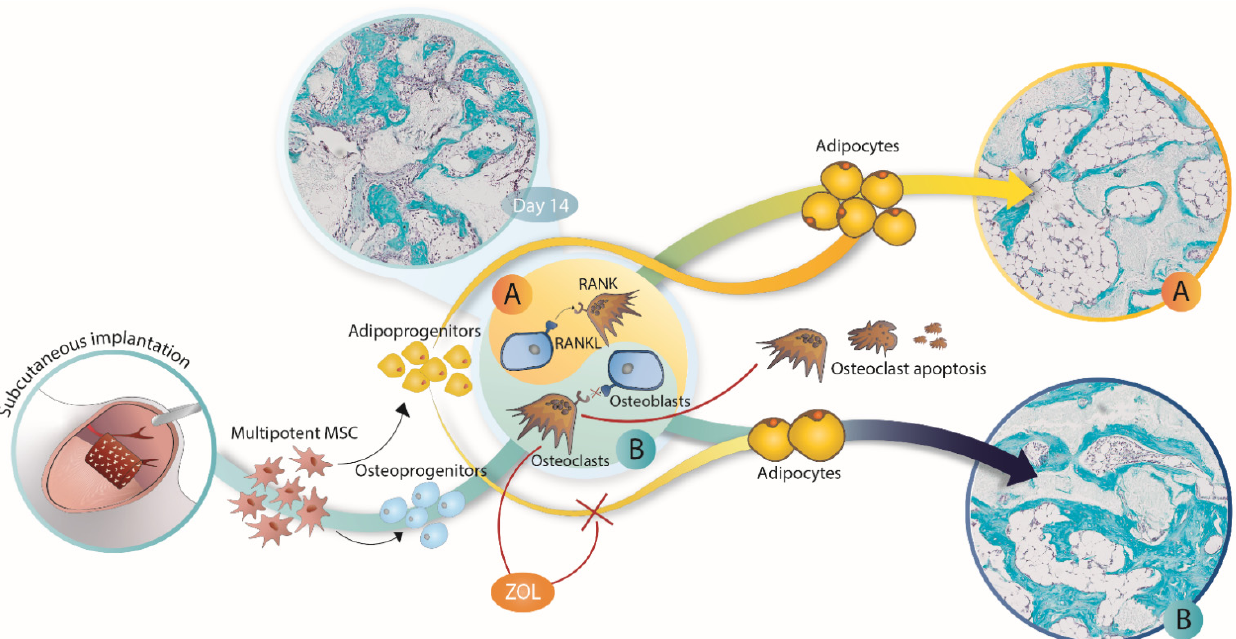
Figure 7. Zoledronate (ZOL) effect on different stages of BMP-induced ectopic bone formation. ZOL applied locally into implants (rhBMP6/ABC/ceramics) did not affect the bone volume on day 14 following implantation but decreased the number of osteoclasts. However, the effect of applied ZOL became apparent at later time points when the bone volume in implants without ZOL ( A ) decreased and was accompanied by predominantly adipogenic bone marrow. On the contrary, the addition of ZOL into implants preserved bone volume and significantly decreased adipogenic bone marrow ( B ). The same effect was achieved when ZOL was applied systemically on day 14 but not on day 21 and later, suggesting that adipogenic differentiation at the ectopic site is an irreversible process.